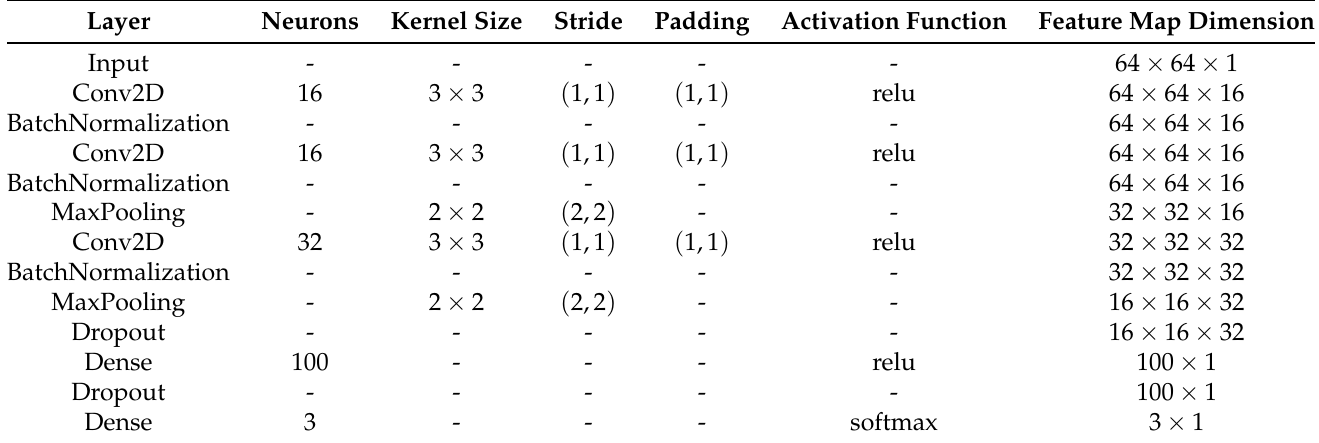
Table 6. CNN used for